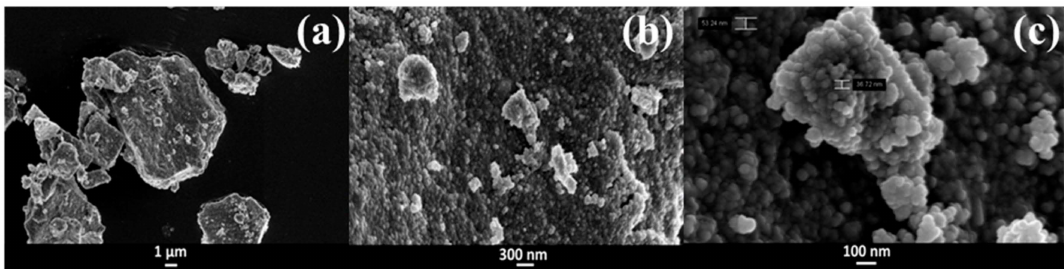
Figure 3. Field emission scanning electron microscopy (FESEM) images of the mesoNsZnO carrier at di ff erent magnification ( a ) 10 KX; ( b ) 50 KX; ( c ) 200